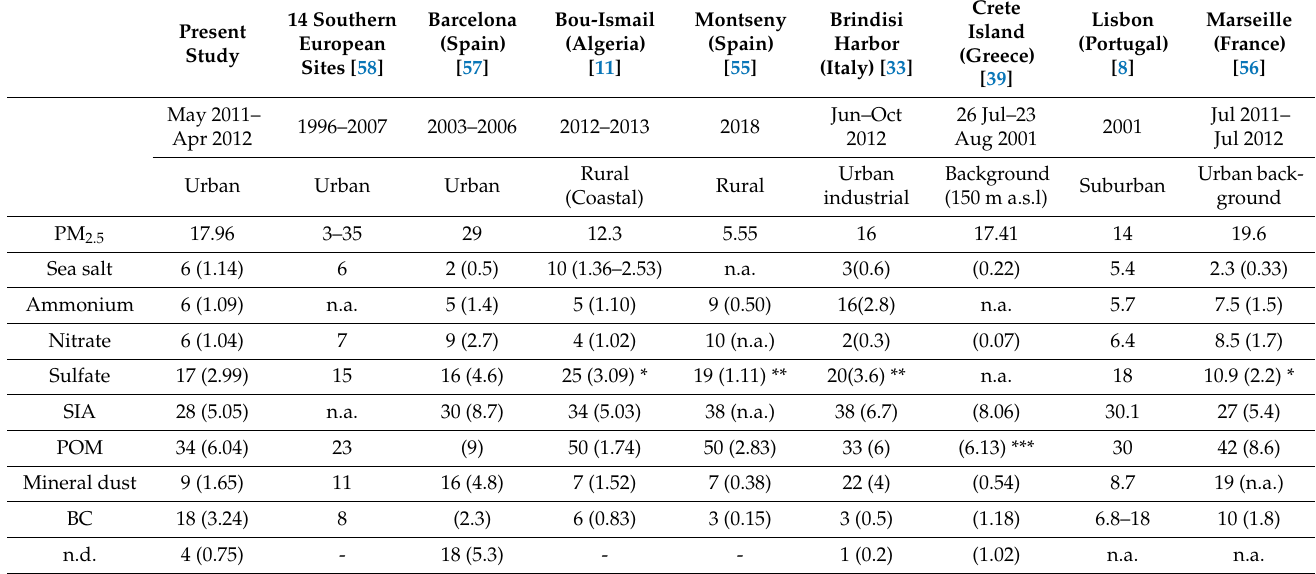
Table 2. Major constituent contributions in % ( µ g/m 3 ) to PM 2.5 . The values are expressed as percent- age average (%) while the values in the brackets show the µ g/m 3 . The values for Putaud et al. [58] identified only the average chemical composition (in %) in 14 southern European sites. n.d. stands for the unidentified component; SIA stands for secondary inorganic aerosols (nss-sulfate, nitrate, and ammonium); n.a.: not available; * estimated from the percentage of nss-sulfate; ** nss-sulfate; *** calculated using a conversion factor of 2.1 to convert OC into